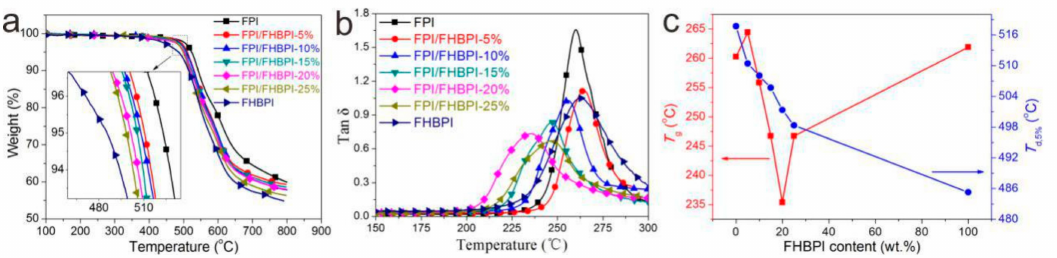
Figure 2. Thermal properties of FPI, FPI / FHBPI composites and FHBPI: ( a ) Thermogravimetric analysis (TGA) curves in N 2 ; ( b ) DMA measurement of tan δ -temperature curves; ( c ) E ff ects of FHBPI content on T d,5% and T g of PI